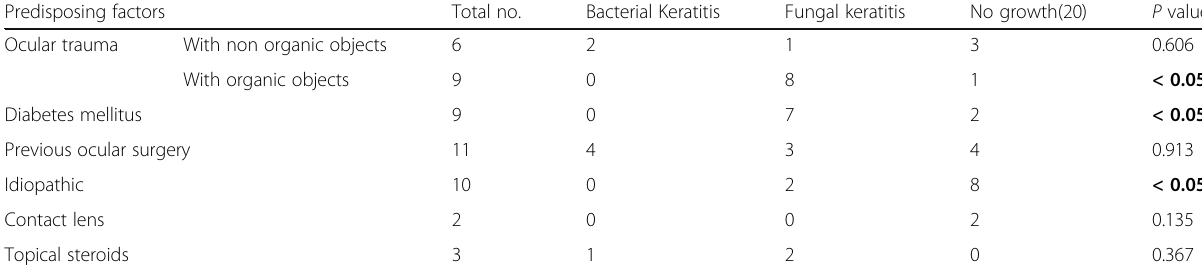
Table 4 Distribution of predisposing factors according to causative agents of keratitis Predisposing